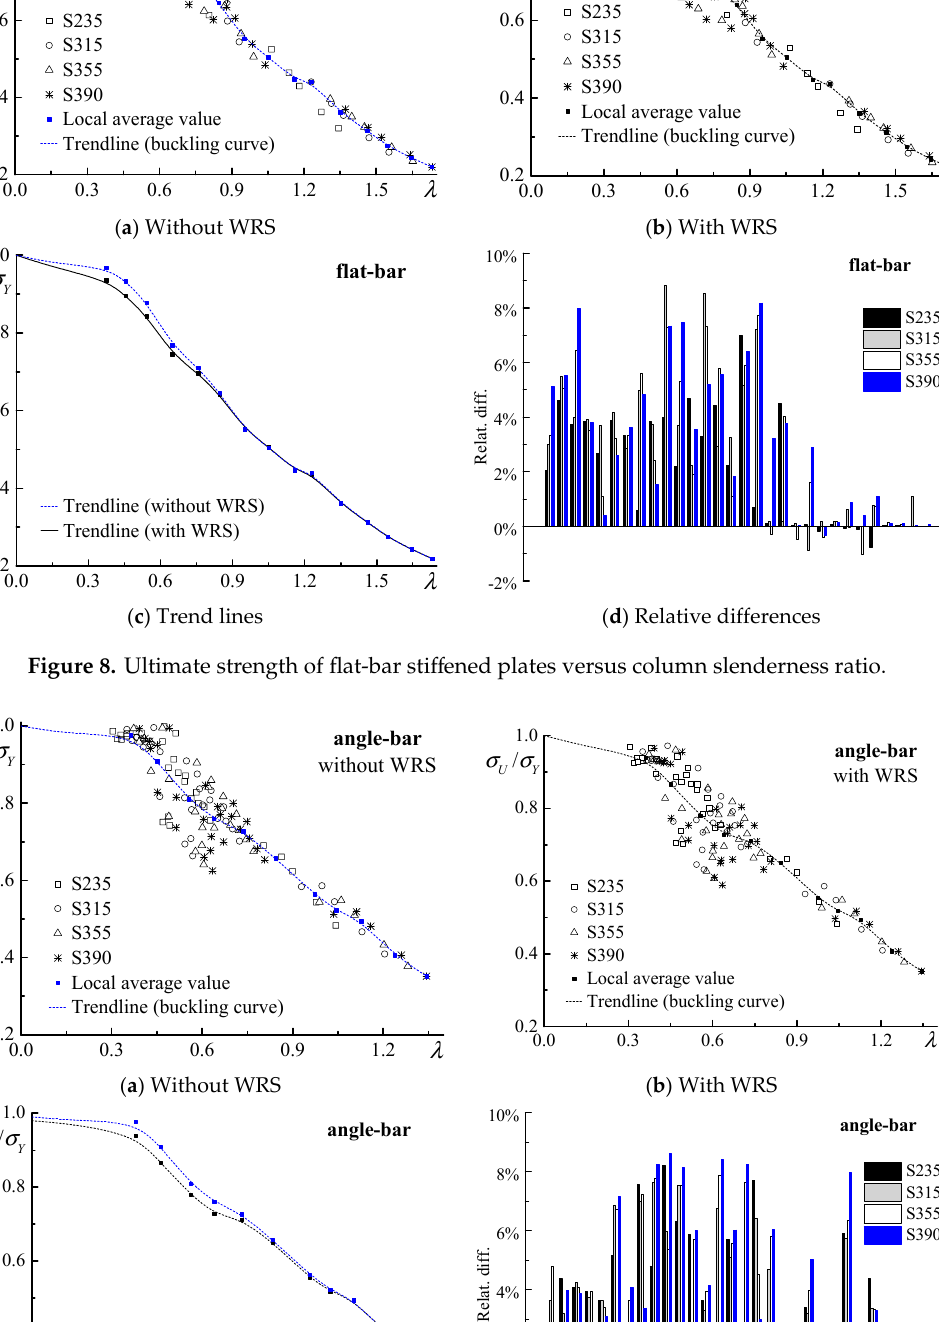
( d ) Relative differences Figure 10. Ultimate strength of tee-bar stiffened plates versus column slenderness ratio.